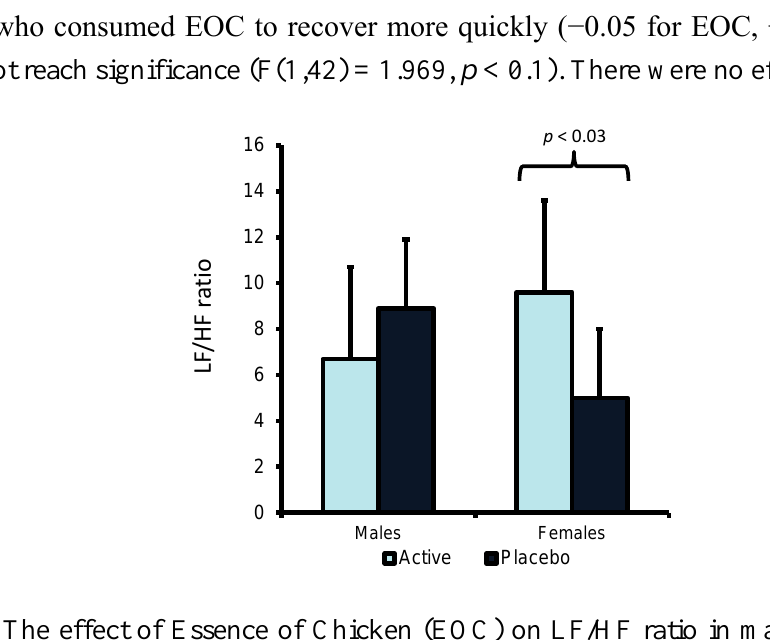
Figure 1. The effect of Essence of Chicken (EOC) on LF/HF ratio in males and females. Data are mean (SE) for Low Frequency/High Frequency (LF/HF) ratio. Females but not males, who drunk EOC rather than placebo, had a higher LF/HF ratio ( p <